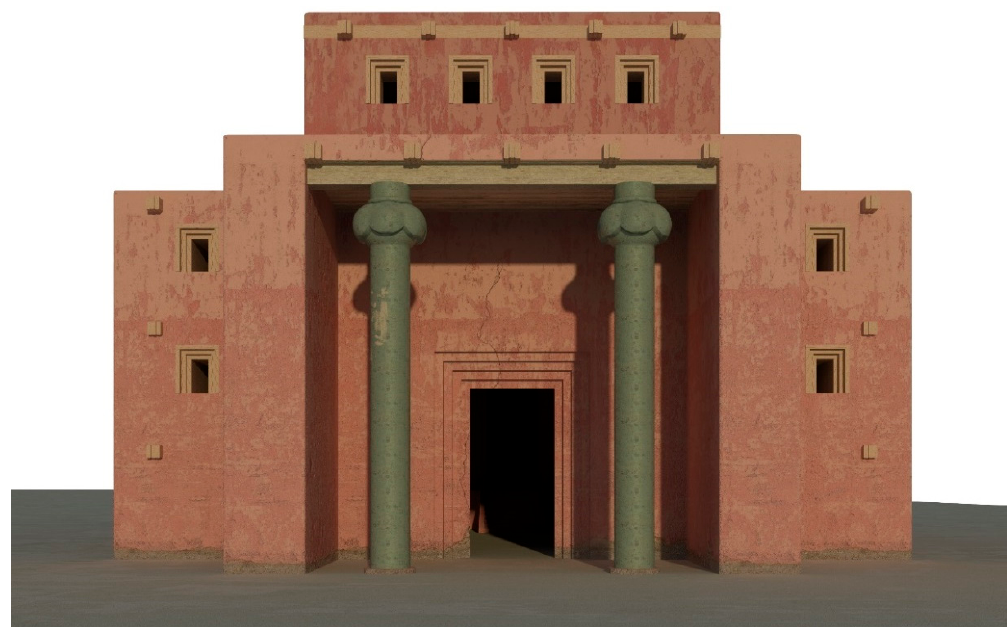
Figure 10. Reconstruction of the façade of Solomon’s Temple based on our analysis of the text and relevant archaeological